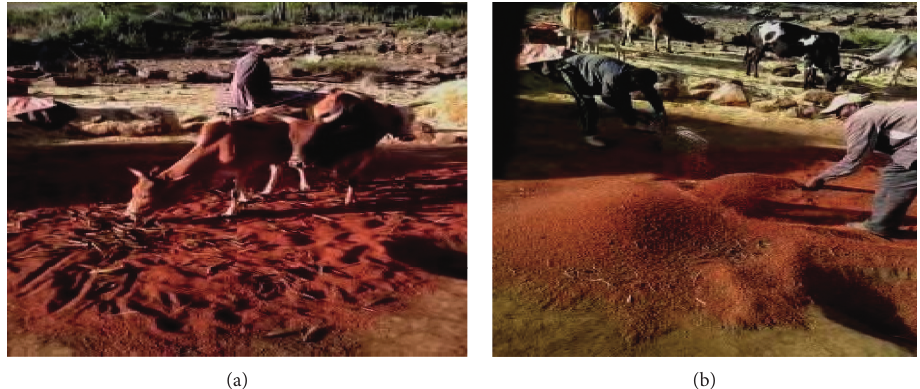
Figure 3: Traditional sorghum threshing using oxen and the popular red seeded sorghum landrace, (“Key-Mashla/Zengada”) in the study areas. Source: local farmers’ during field visit,